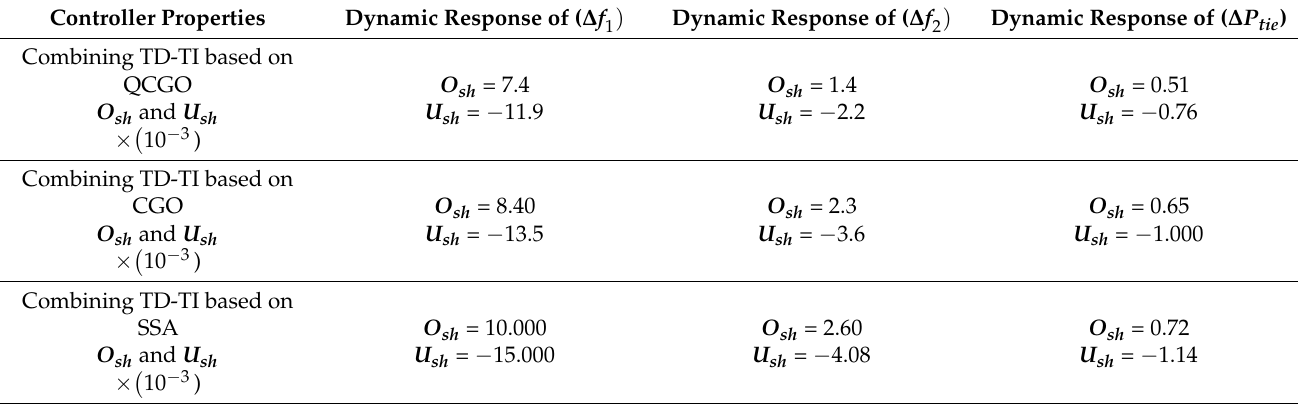
Table 16. The transient response specifications of the presented system for case A.3.